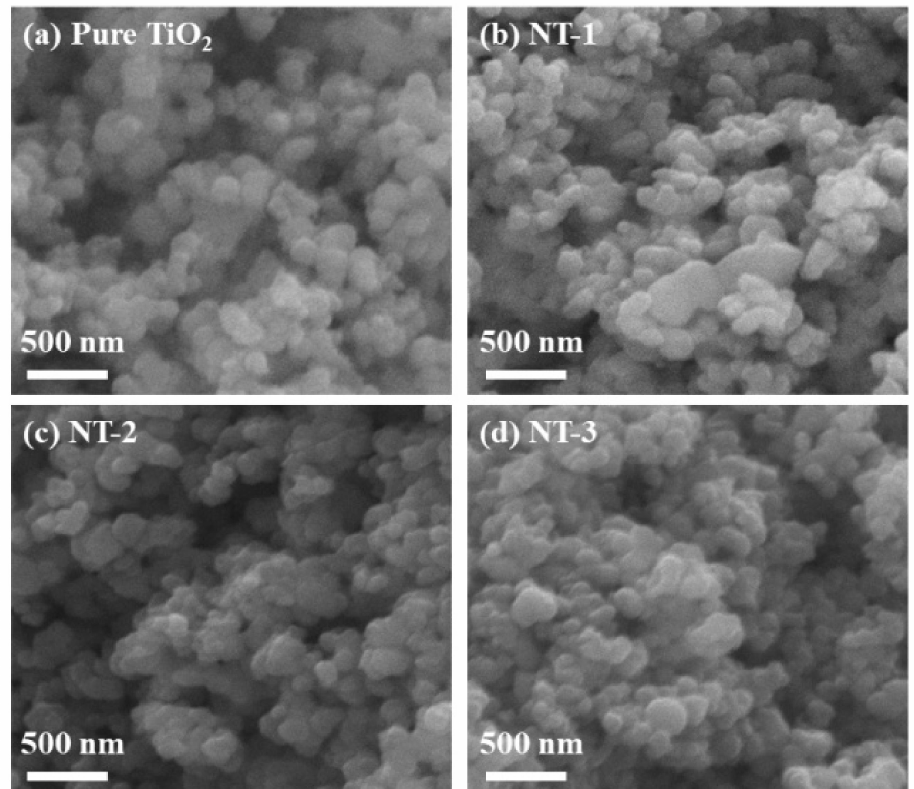
Figure 3. SEM images of ( a ) Pure TiO 2 , ( b ) NT-1, ( c ) NT-2 and, ( d )